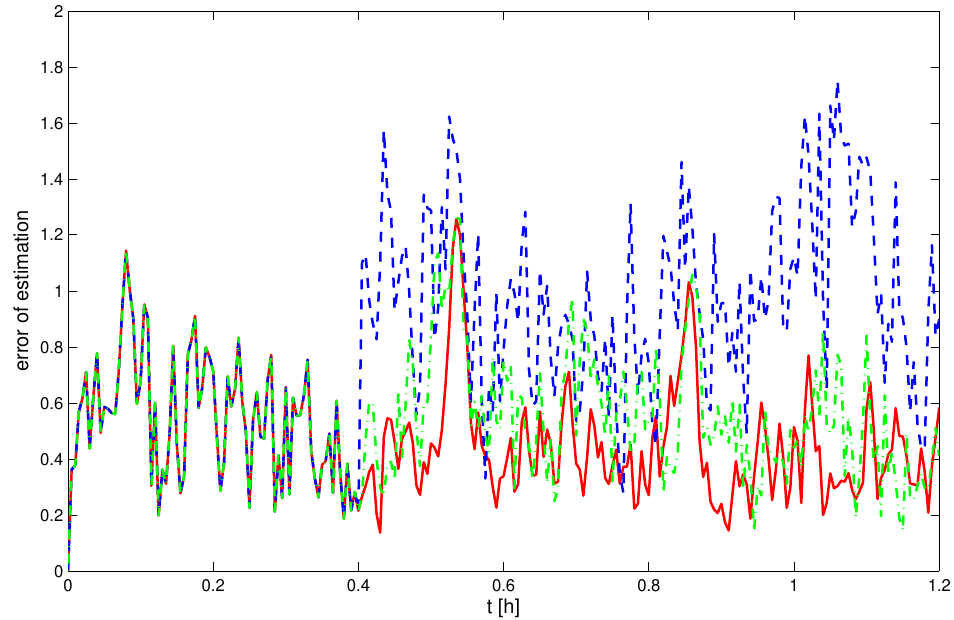
Figure 5. Trajectories of the Euclidean norm estimation errors calculated by the proposed scheme (solid lines) and the scheme II (dash-dotted line) and the scheme III (dashed